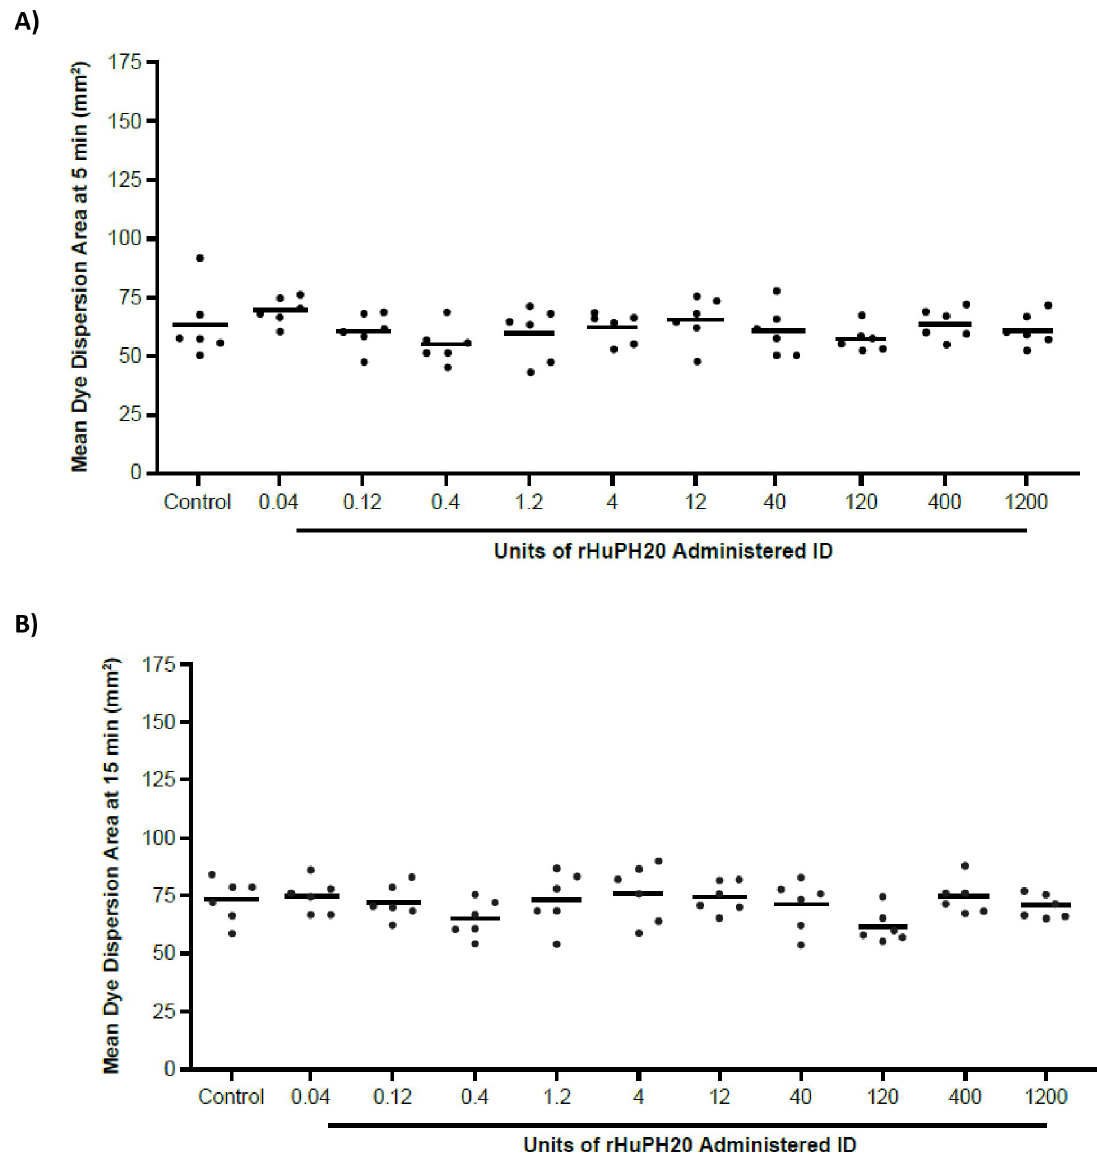
Fig 6. Dye dispersion: Characterization of dispersive effects at a distal site after ascending intradermal rHuPH20 dose administration at a contralateral skin site. Measurement of dye dispersion area (A) 5 minutes and (B) 15 minutes post-dye injection. Each point represents the mean of duplicate measurements from one animal; the bar represents the mean for all animals. ID, intradermally; rHuPH20, recombinant human hyaluronidase